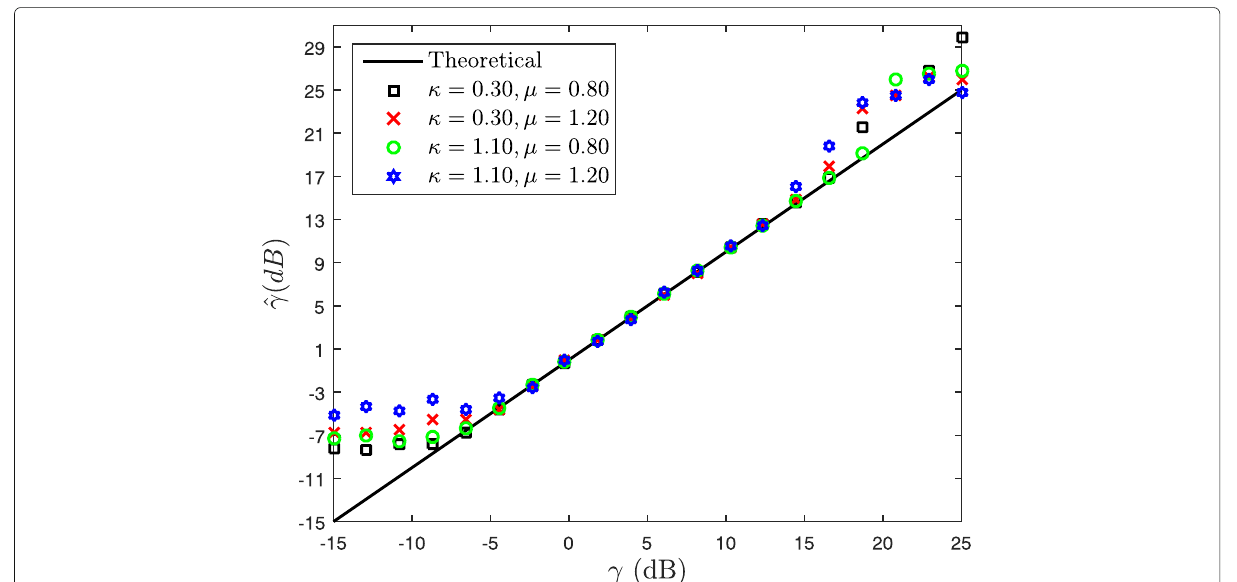
Fig. 8 Mean of the estimate ˆ γ as a function of SNR in dB for fading κ − μ for N = 5 × 10 4 and 64-QAM modulation considering different values of κ and μ